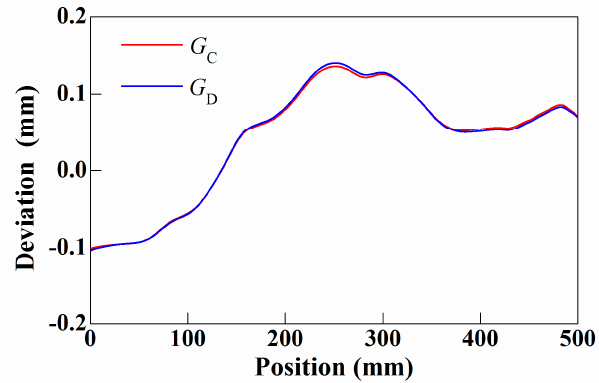
Figure 35. Two positional relation curves.